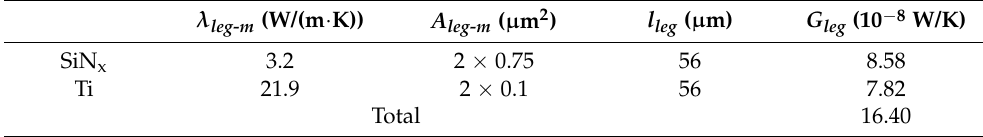
Table 3. The calculation of the micro-bolometer pixel thermal conductivity.